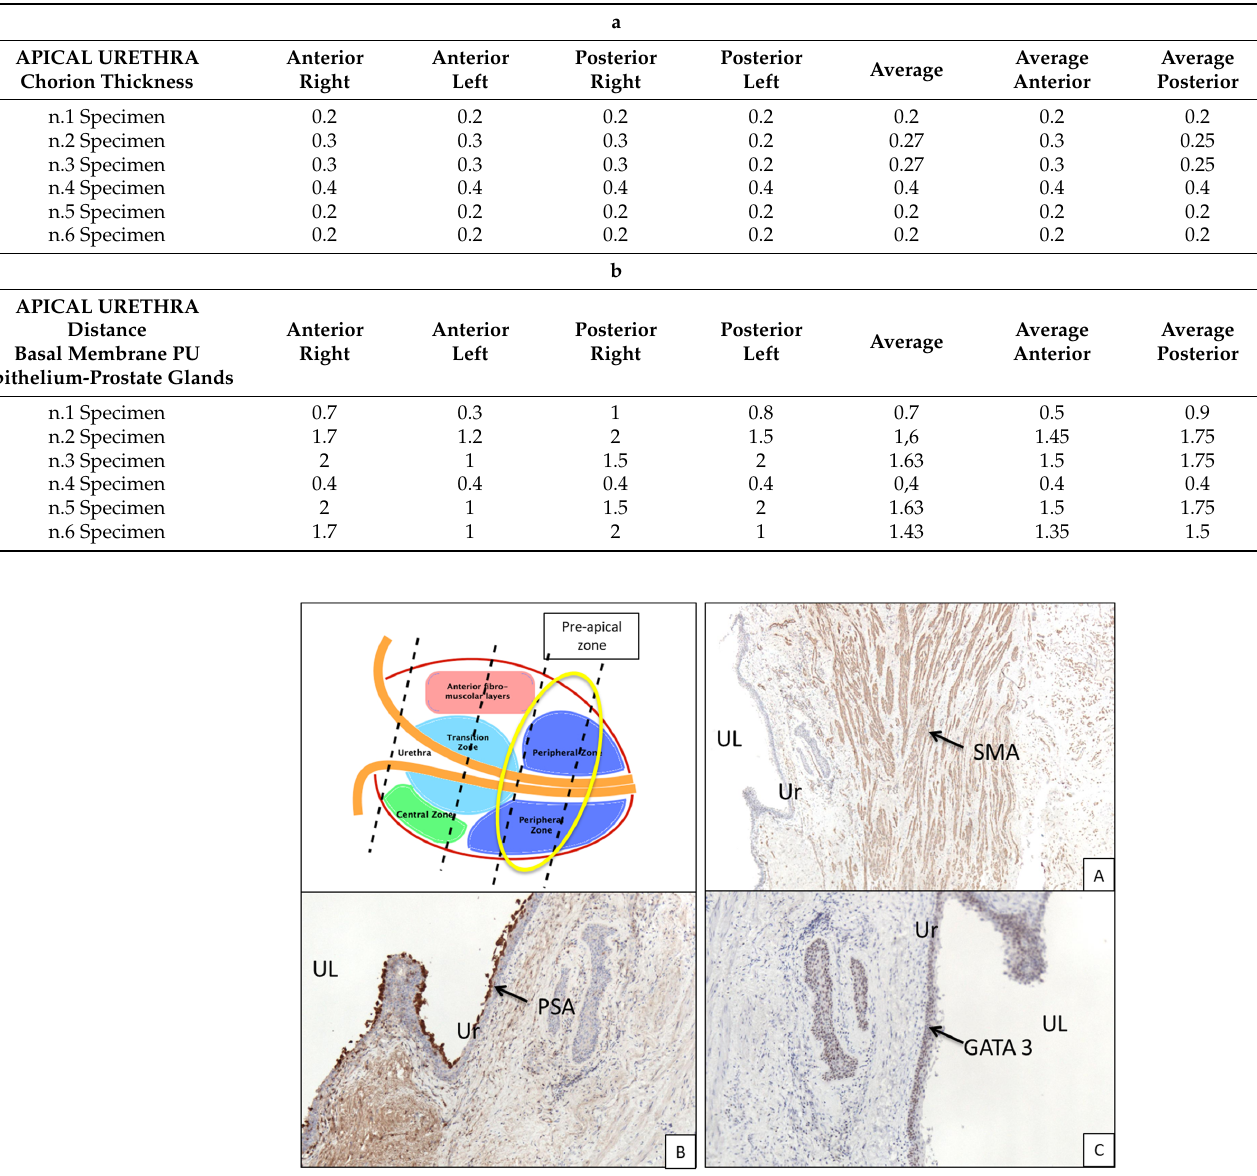
Table 4. a. Chorion thickness at the level of the apical PU. b. Distance between basal membrane of the PU epithelium and prostate glands at the level of the apical PU.